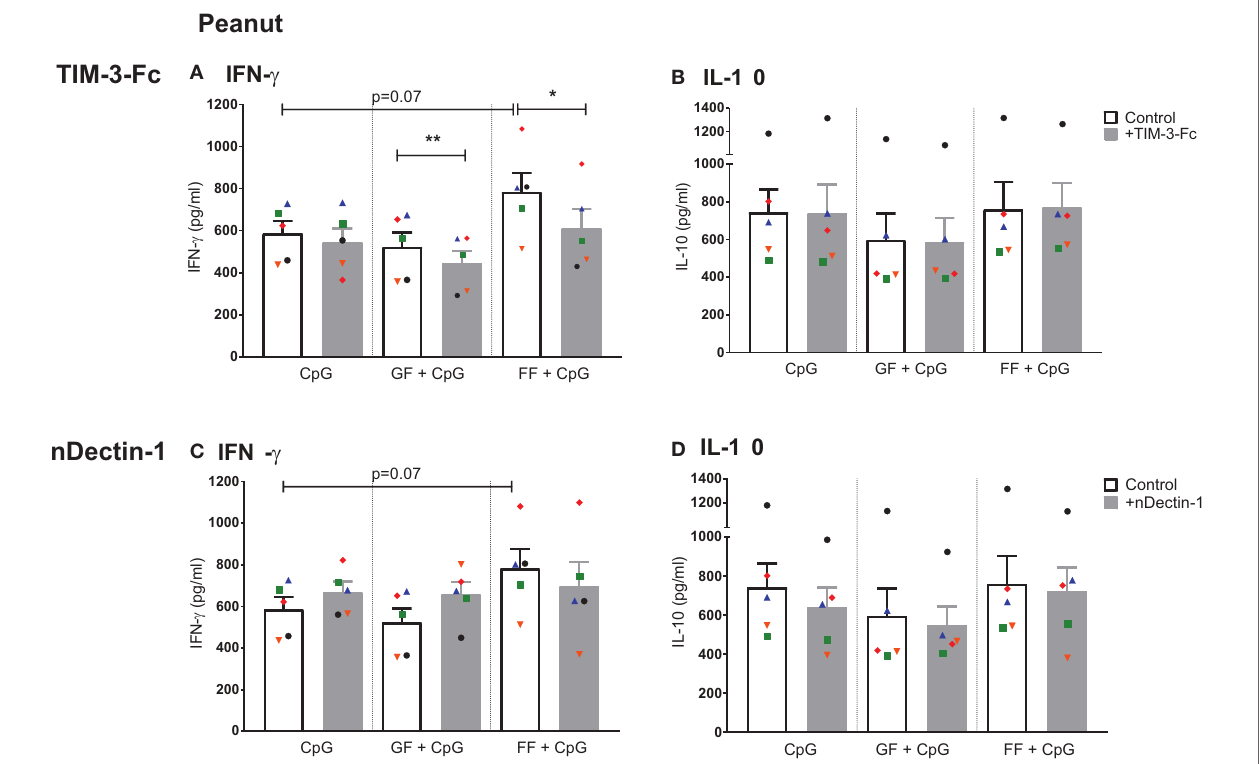
FigUre 8 | Neutralization of galectin-9 abrogates IFN- γ production in the peanut-specific co-culture model, while neutralization of the dectin-1 receptor does not affect IFN- γ and IL-10 production. Addition of TIM-3-Fc to the peanut-specific co-culture abrogated additional IFN- γ production by short- and long-chain fructo-oligosaccharides (scFOS/lcFOS) (FF), and also decreased IFN- γ production upon combined exposure to CpG oligodeoxynucleotides and scGOS/lcFOS (GF) (a) . IL-10 production was not influenced by addition of TIM-3-Fc (B) . Neutralization of dectin-1 receptor on HT-29 cells did not affect IFN- γ or IL-10 production (c,D) . Data represent n = 5 peanut-allergic patients, mean ± SEM, * P < 0.05, ** P < 0.01, *** P < 0.001 by one-way ANOVA or Student’s paired t